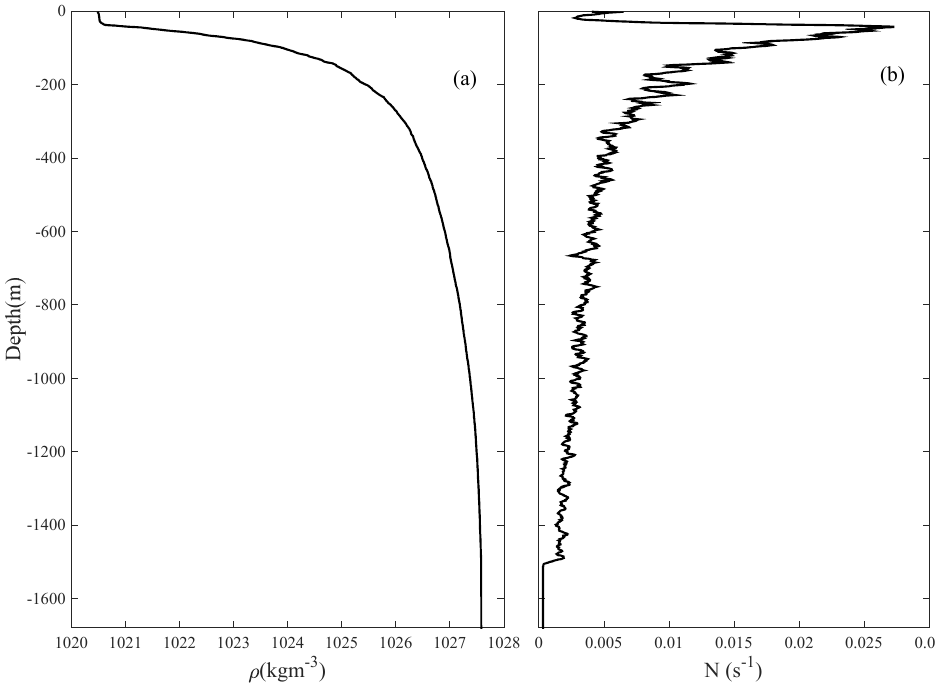
Figure 3. ( a ) Seawater density and ( b ) buoyancy frequency profiles computed from WOA2009.